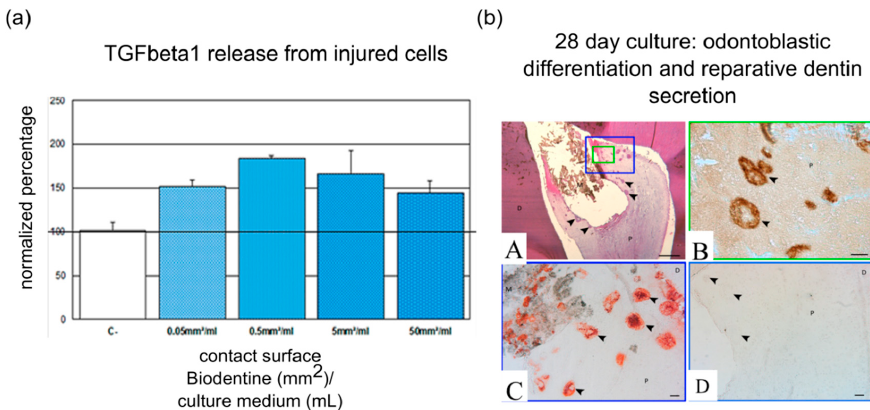
Figure 1. Biodentine and its effect on dental pulp regeneration. ( a ) Regardless of surface area, Biodentine induces TGF β‐ 1 release, a major chemoattractant for DPSC, from injured pulp cells; ( b ) Expression of odontoblast markers after pulp capping with Biodentine in entire tooth culture model. Numerous mineralization foci (arrowheads) can be viewed beneath the biomaterial after culture for two weeks and hematoxylin and eosin staining ( A ). Dentin sialoprotein ( B ) and nestin ( C ) are expressed in the mineralized foci, which represent an early form of reparative dentin ( D ). Abbreviations: D, dentin; P, pulp; M, biomaterial. Scale bars: A = 500 μ m; B,C,D = 100 μ m. Modified with permission from [18].